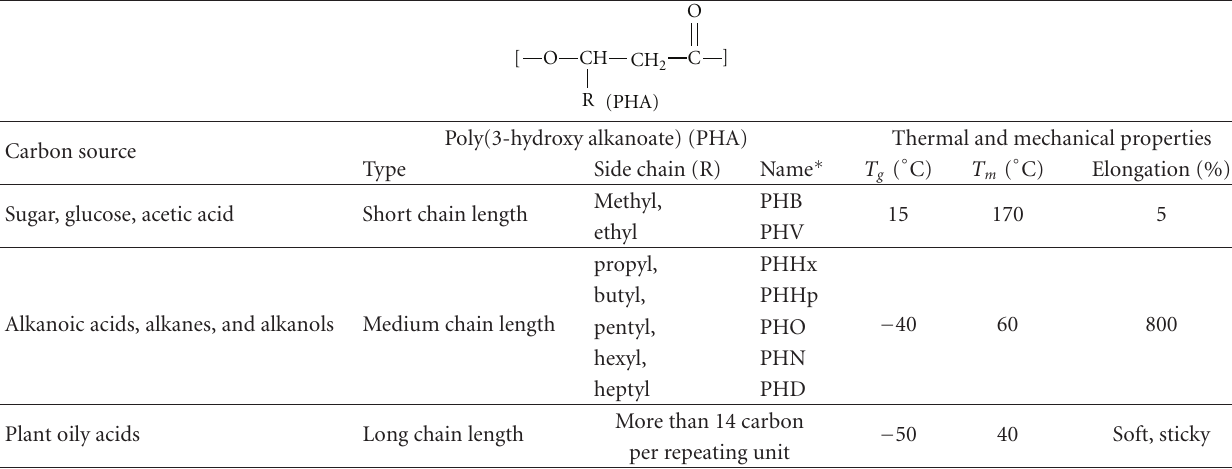
Table 1: Classification of the bacterial